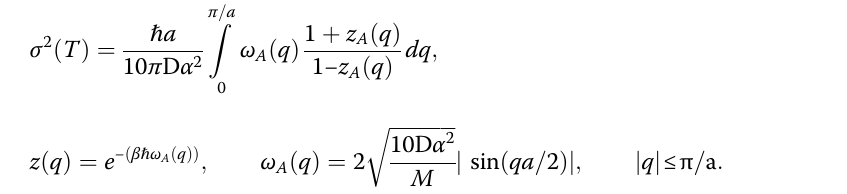
ffiffiffiffiffiffiffiffiffiffiffiffiffi